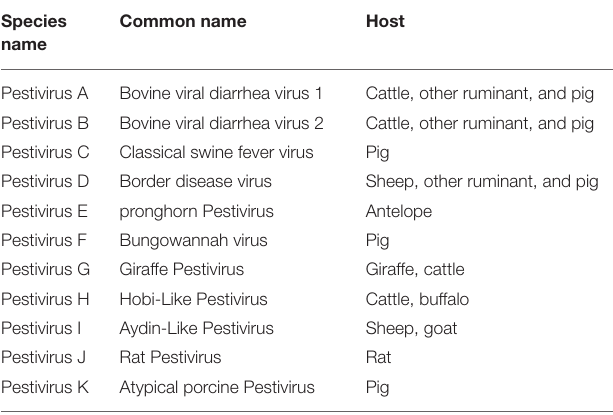
TABLE 1 | Member of the genus Pestivirus, adapted from Smith et al.